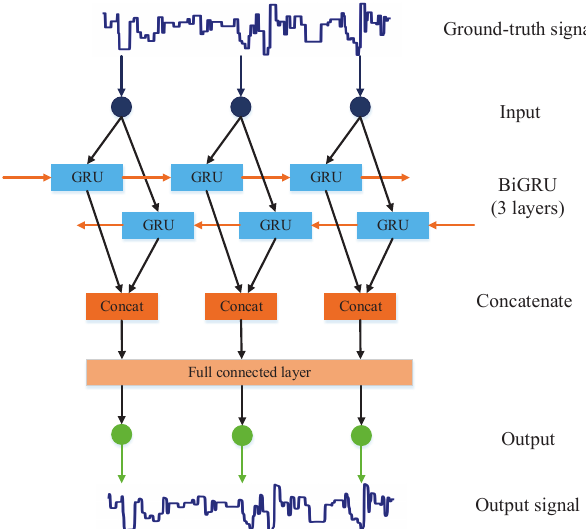
Figure 3. The network architecture of signal processing model based on BiGRU, which is composed of a three-layer BiGRU and a fully connected layer. Given a ground-truth signal, the signal processing model will output its corresponding filtered signal after